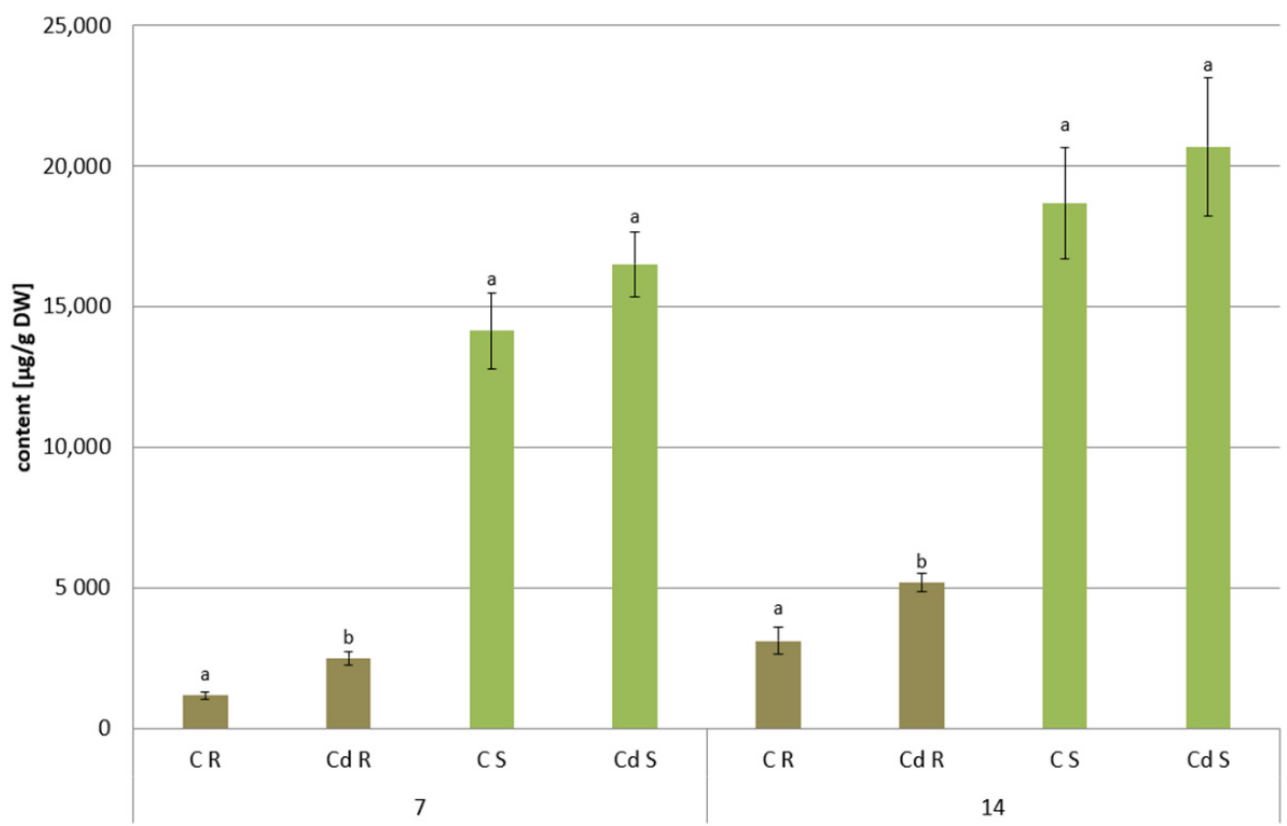
Figure 23. The content of saponins in C. officinalis roots (R) and shoots (S). Bars which do not share a common letter are significantly different ( p < 0.05).